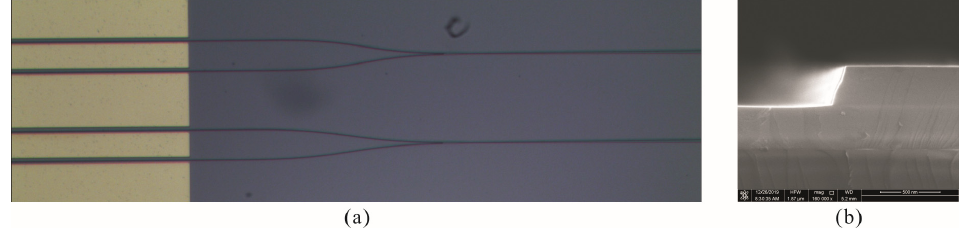
Figure 4. ( a ) Microscopic image of the part of the modulator; ( b ) The SEM image of the etched waveguide cross section.